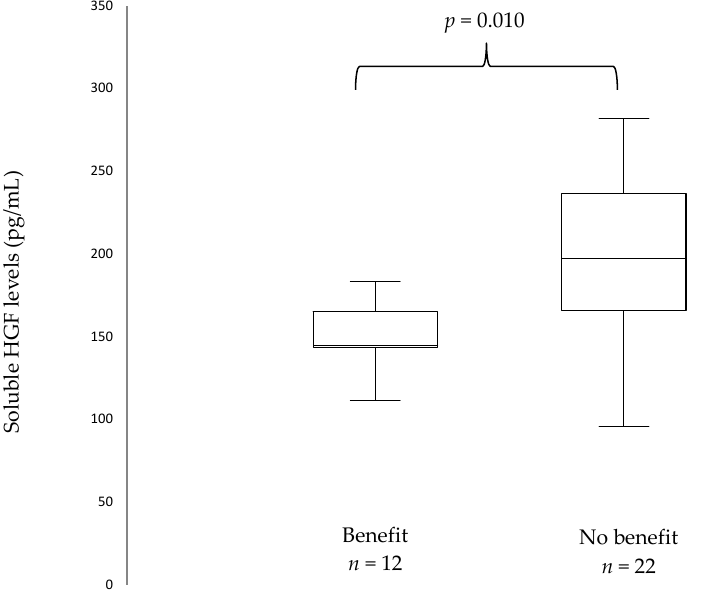
Figure 2. Box plots showing baseline soluble Hepatocyte Growth Factor (sHGF) levels in patients with and without clinical benefit. The median is indicated by the line within the box, the boundaries of the box indicate the 25th and 75th percentile and the whiskers the 10th and 90th